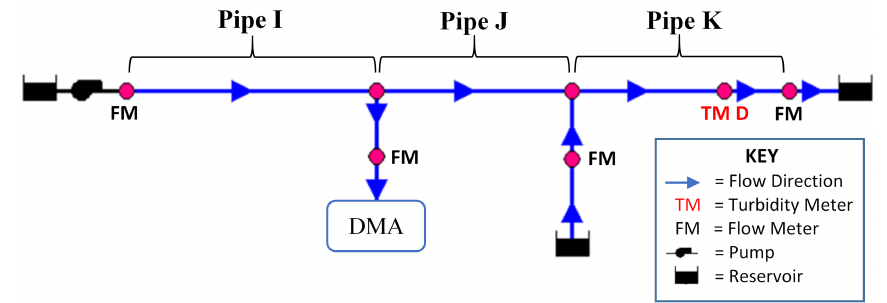
Figure 2. Schematic of Site 3. DMA, District Metered